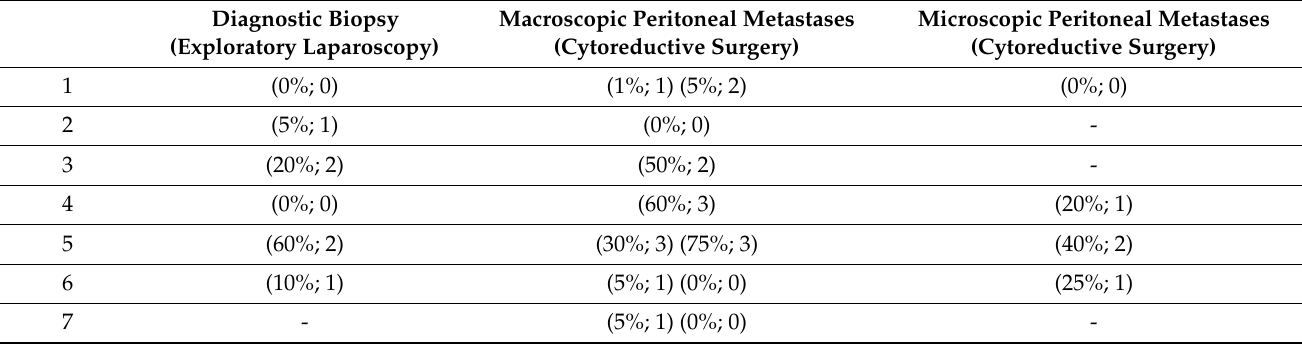
Table 2. FR α expression in patients with microscopic peritoneal metastases (percentage of FR α positive tumor cells; staining intensity).